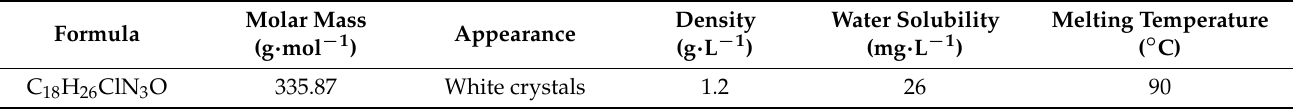
Table 1. Some physicochemical characteristics of 2-hydroxychloroquine